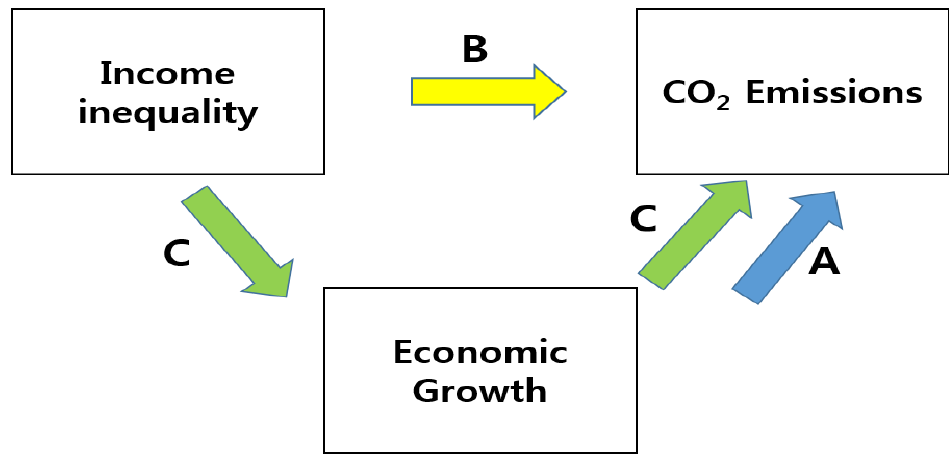
Figure 1. The relationship of income inequality, economic growth, and CO 2 emissions. Source: Author’s own elaboration based on Bae (2018) [5].